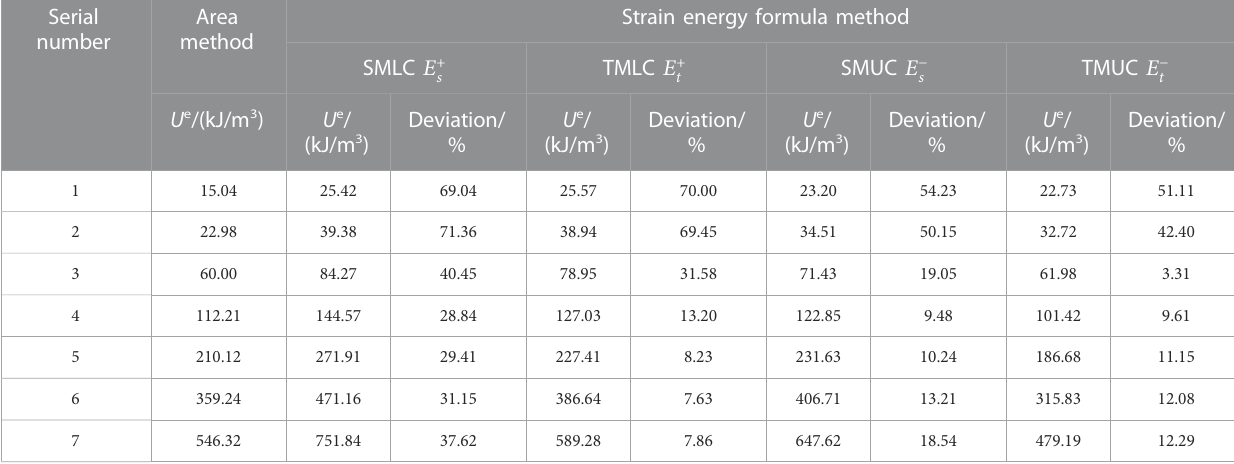
TABLE 2 Results of elastic strain energy calculated by different elastic modulus ( σ 3 = 20 MPa). Serial